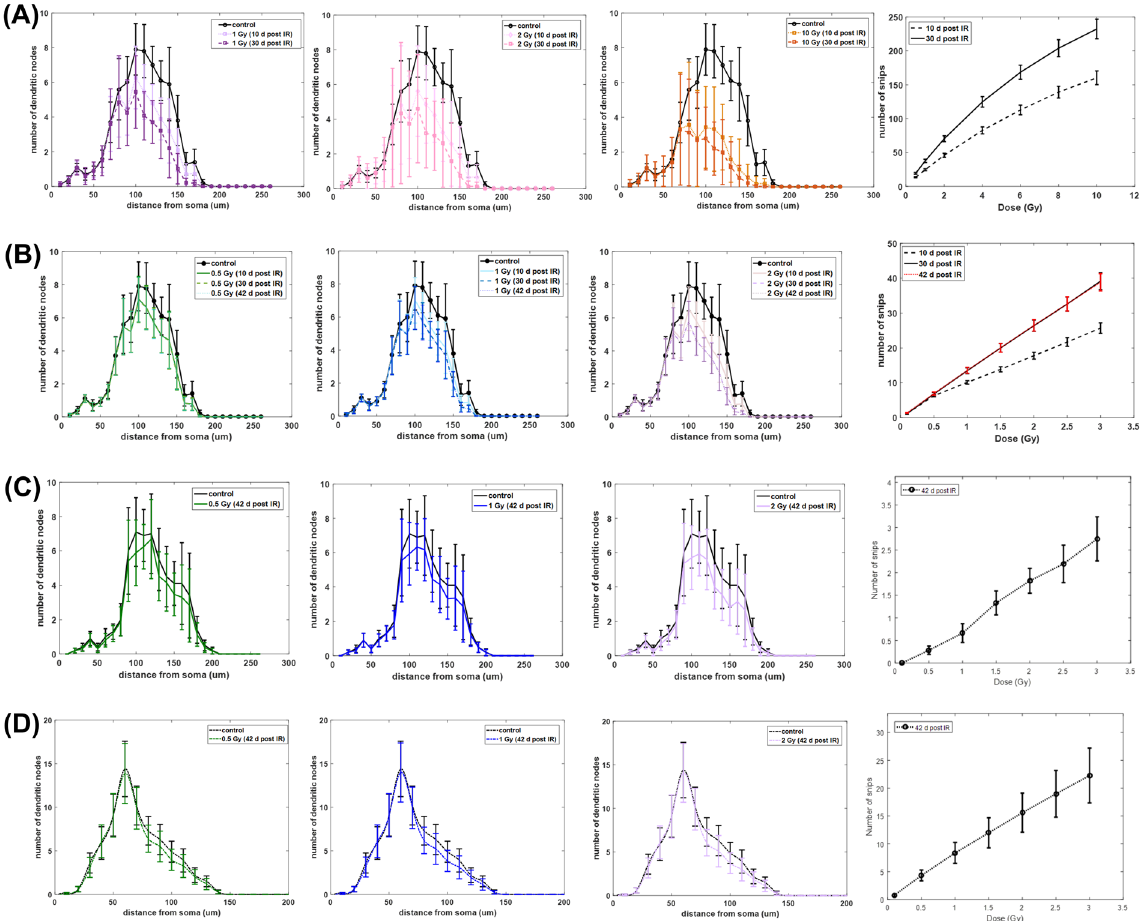
Figure 6. Sholl analysis and dose-dependent snip distribution of GCL neuron ( A , B ) and CA1 pyramidal neuron (C,D). ( A ) GCL neuron exposed to γ -rays, ( B ) GCL neuron exposed to proton IR, ( C ) Apical CA1 pyramidal neuron exposed to proton IR, ( D ) Basal CA1 pyramidal neuron exposed to proton IR. (Error bars represent standard error of the